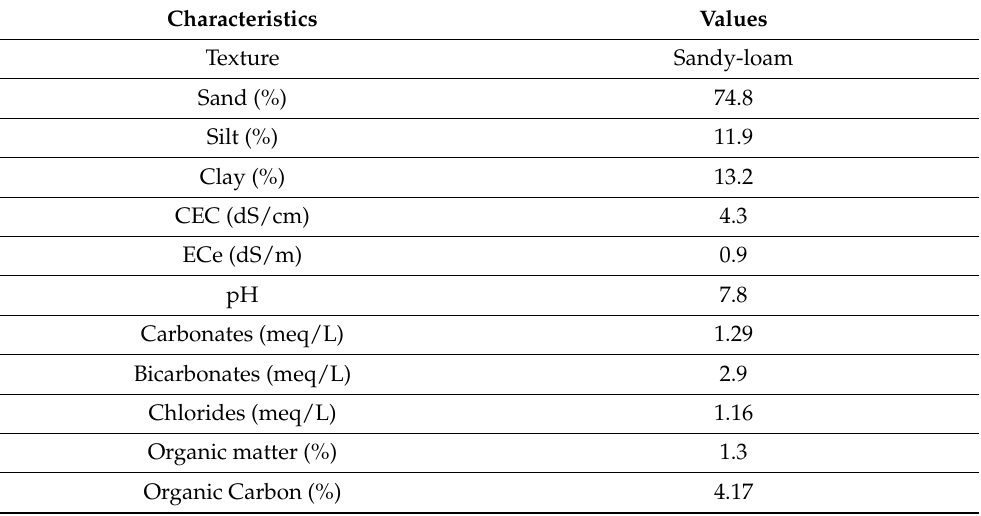
Table 1. The physical and chemical properties of the soil used in the experiment.